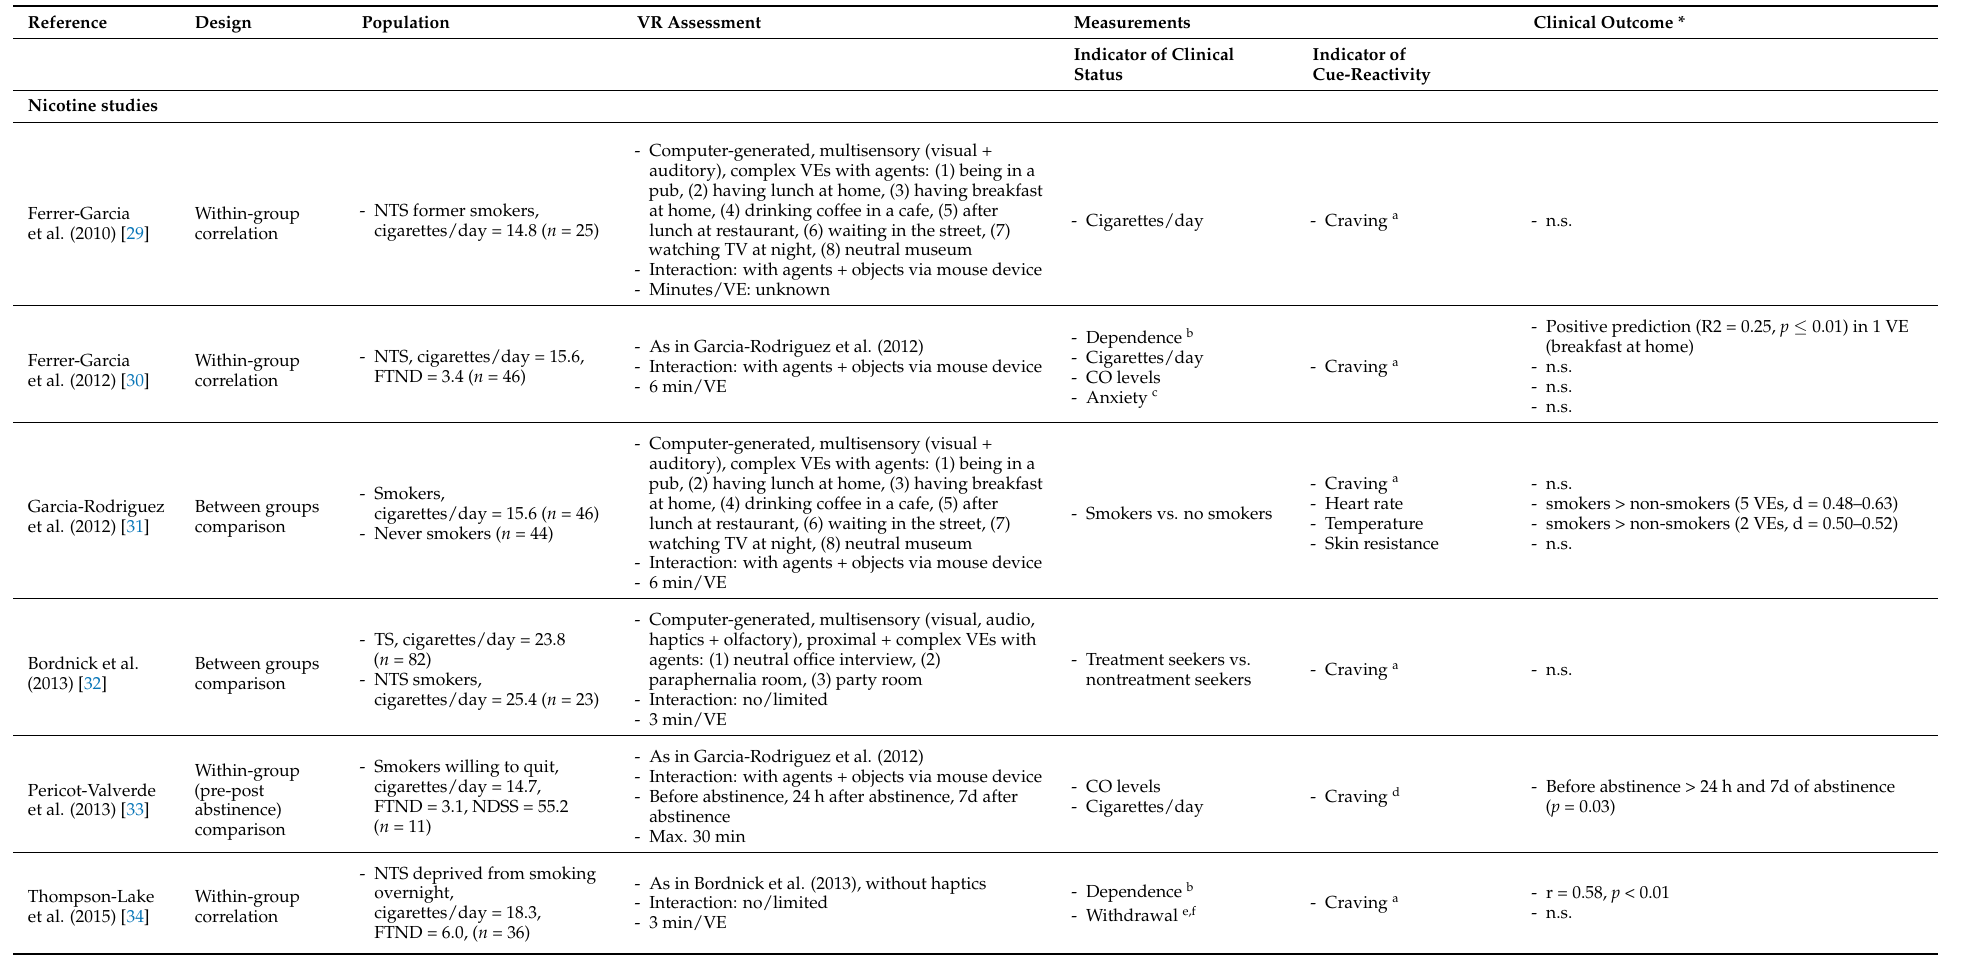
Table 2. Virtual reality assessment